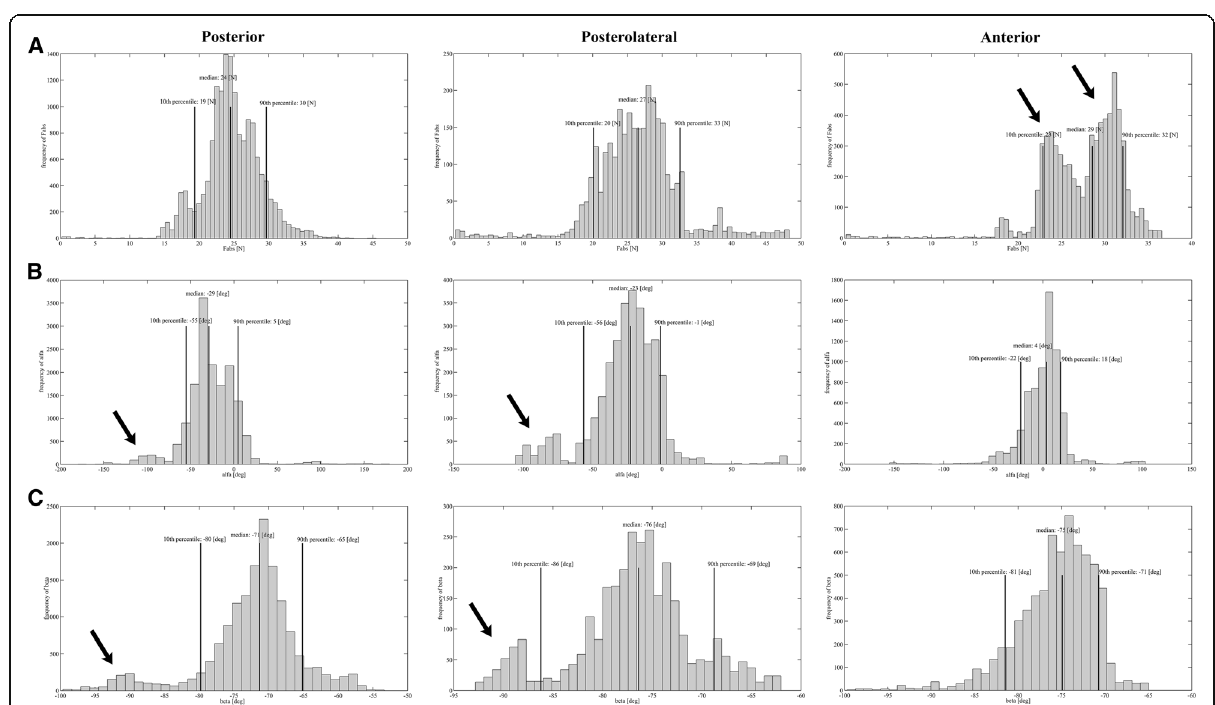
Fig. 4 Histograms presenting the data points for F abs , alfa and beta of each compartment. Histograms presenting the median, 10th and 90th percentile for frequency of total absolute force (F abs ), horizontal angle ( α ) and vertical angle ( β ) data points in the posterior, posterolateral and anterior compartment of both cadaver elbows. a Histogram showing F abs . The two black arrows point to two separate peaks in frequency of F abs , around 23 N and 30 N in the anterior compartment. b Histogram showing α . α is positive to the right, and negative to the left. The two black arrows point to a smaller peak around − 90° for α and β in the posterior and posterolateral compartment. c Histogram showing β . β is positive upward, and negative downward. The two black arrows point to a smaller peak around − 90° for α and β in the posterior and posterolateral